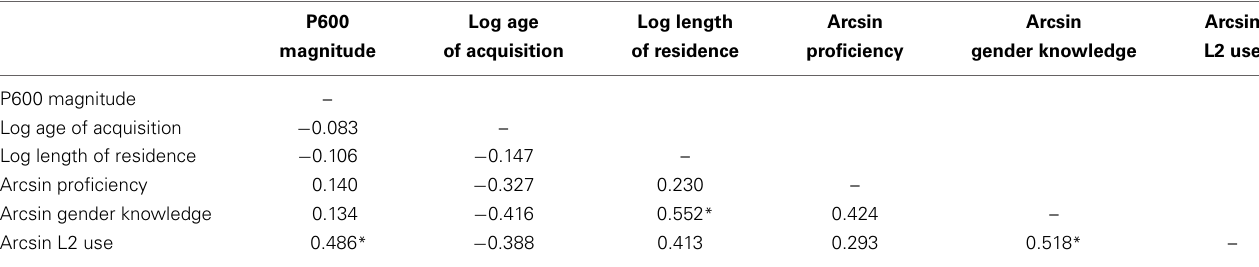
Table 3 | Correlation matrix for the dependent measure and the participant characteristics variables used in the regression model. P600 Log age Log length Arcsin Arcsin Arcsin magnitude of acquisition of residence proficiency gender knowledge L2 use